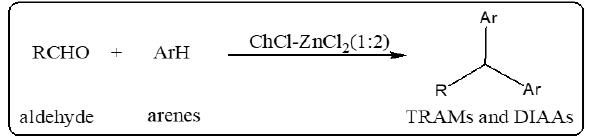
Figure 3: Synthesis of triarylmethanes and diarylaalkanes by using ChCl-ZnCl (1:2). a 2 a See Wang et al. [29] for detailed reaction components and conditions.